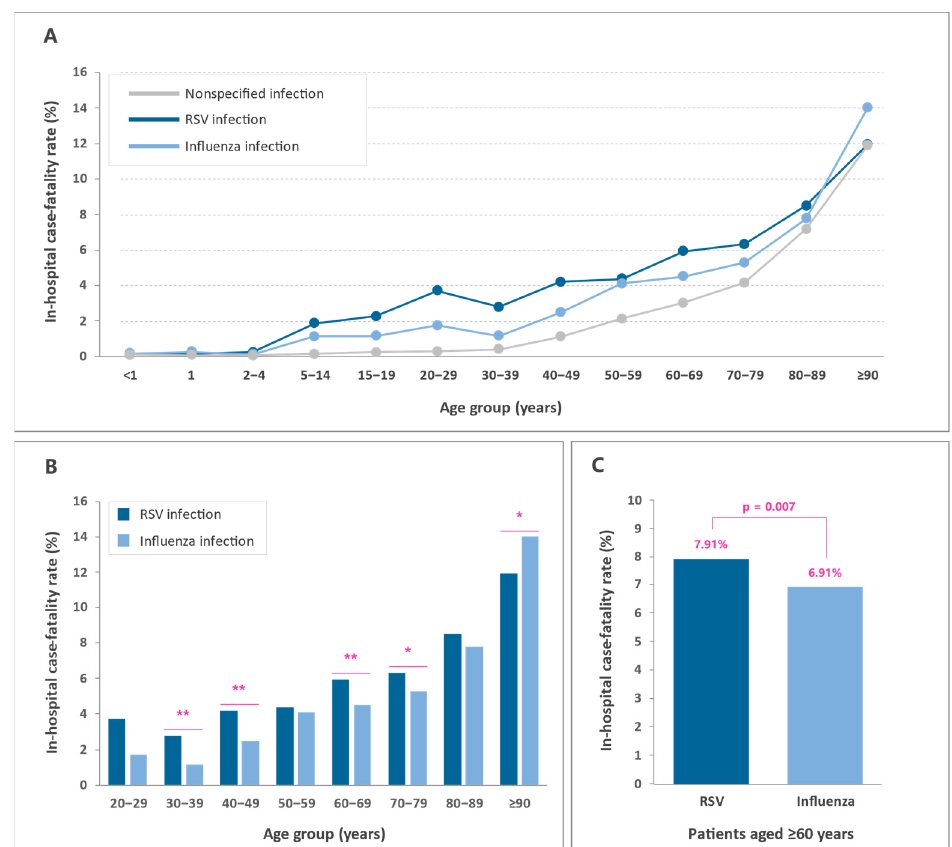
Figure 4. In-hospital case fatality rates for lower respiratory tract infections in Spain between 2012 and 2020. ( A ) Mortality rates for nonspecified infection, RSV infection, and influenza infection by age group. ( B ) Mortality rates for RSV infection and influenza infection in adult patients ( ≥ 20 years) by age group. ( C ) Mortality rates for RSV infection and influenza infection in patients aged 60 years or older. Rates are expressed as the percentage of deaths per inpatient population. * p ≤ 0.05; ** p ≤